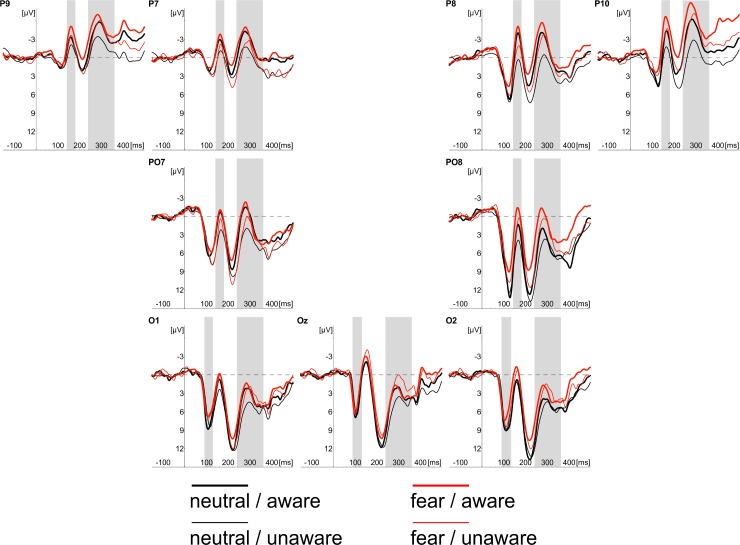
Grand average of ERPs recorded in PDW task at occipital (O1, Oz, O2) and occipito-temporal (P7, PO7, P9, P8, PO8, P10) electrodes in response to neutral (black lines) and fearful faces (red lines).Responses obtained in “unaware” (thin lines) and “aware” trails (thick lines) are also shown. Time windows for the region of interest (P1 component; 90-115ms post-stimulus; N170 component; 145-180ms post-stimulus; EPN component 240–340 ms post-stimulus) are highlighted at corresponding electrodes; time 0 indicates stimulus onset.